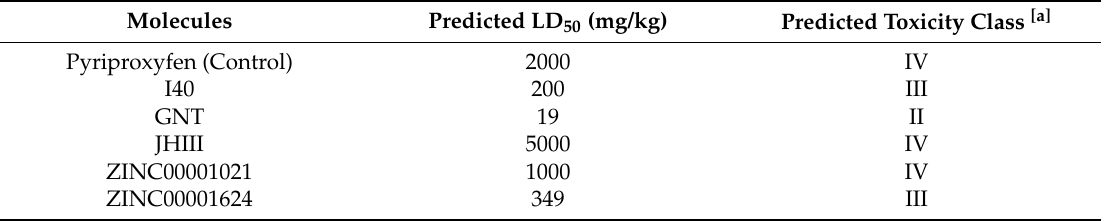
Table 4. Oral toxicity prediction results for input